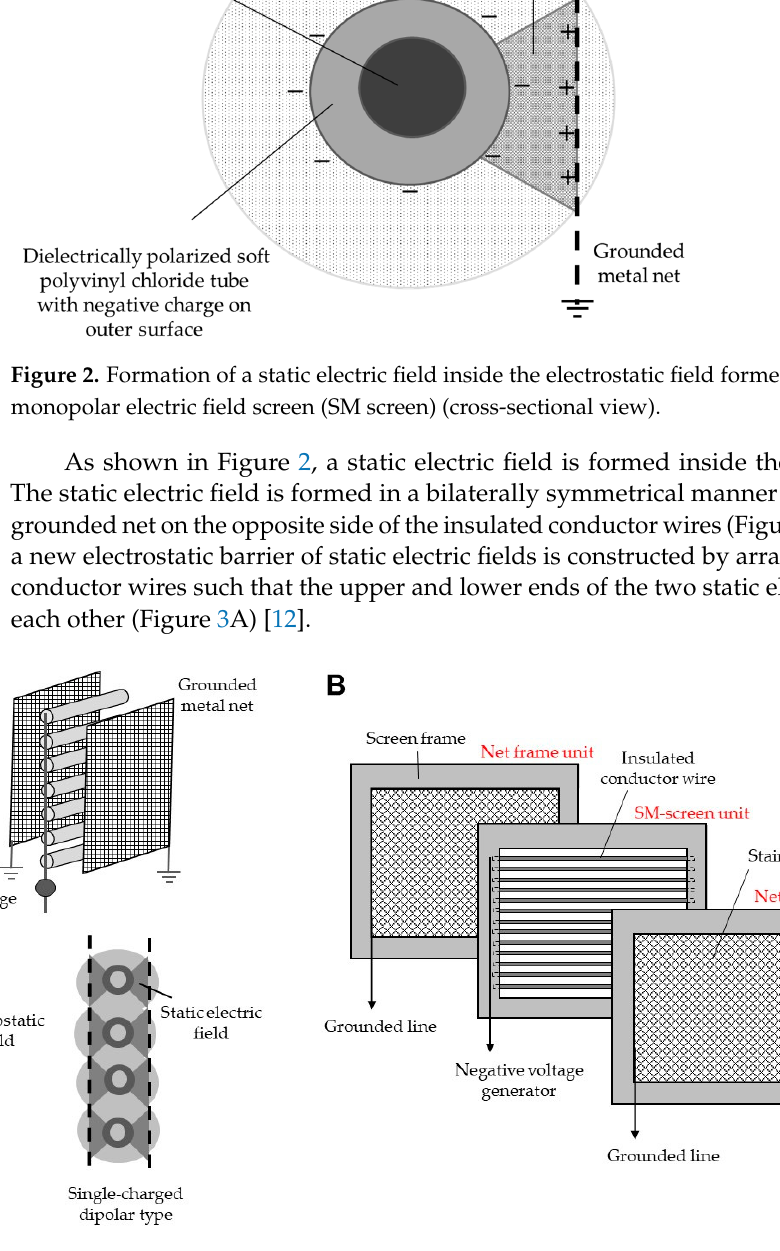
Figure 3. ( A ) Comparative representation of single-charged monopolar and dipolar electric field screens forming an electrostatic field and static electric field, respectively. ( B ) Schematic representation of a single-charged dipolar electric field screen (SD screen) consisting of three units. Two net frame units are placed on each side of the SM screen unit.